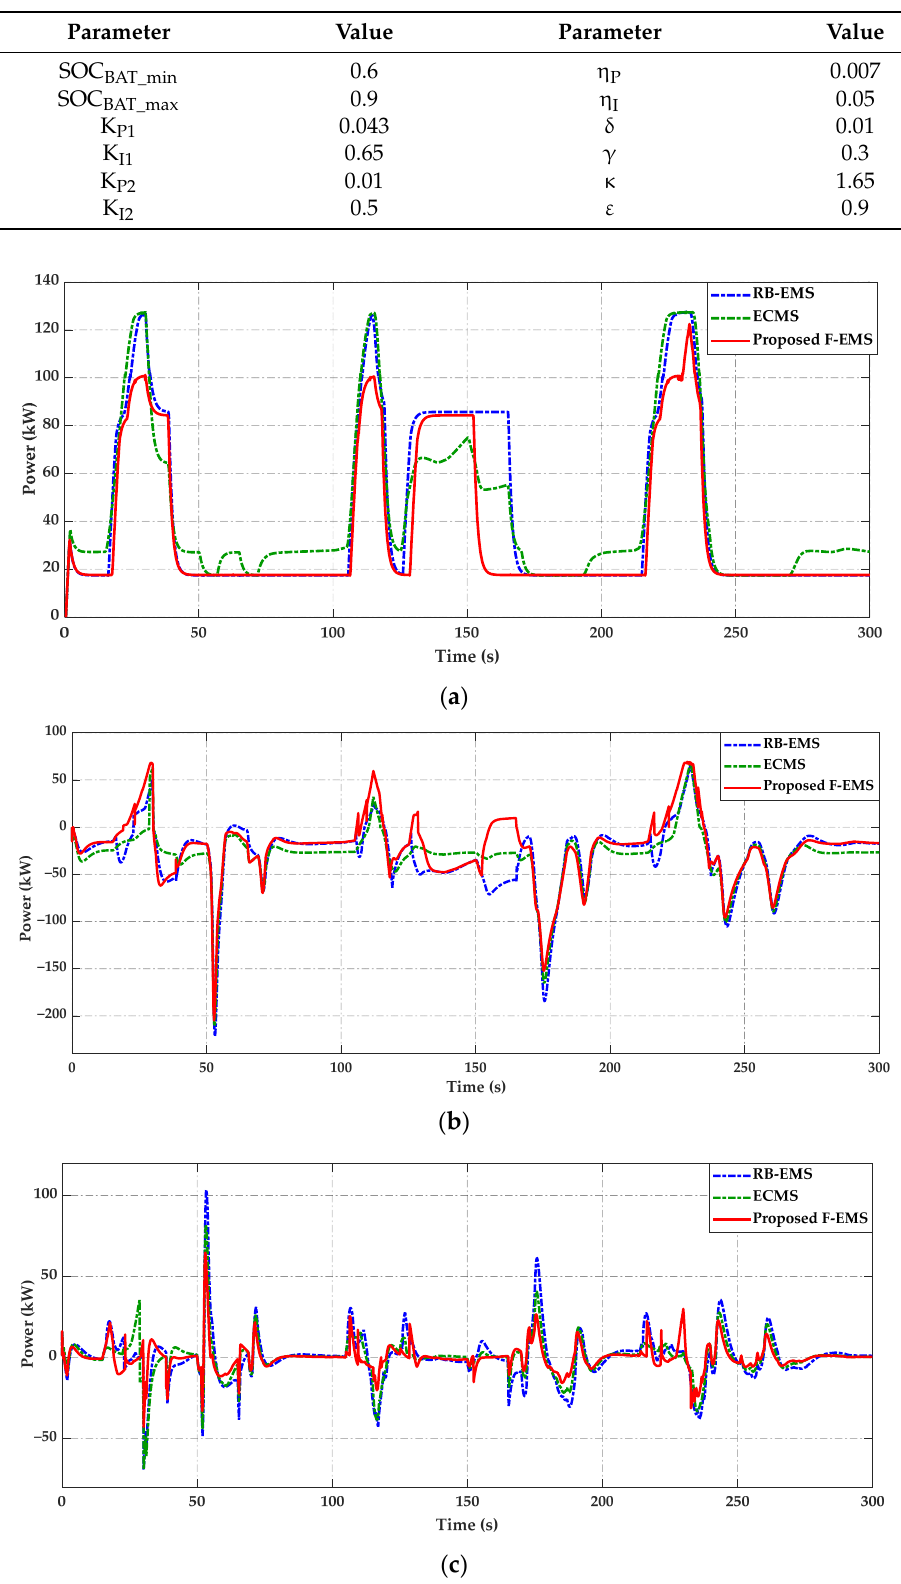
Figure 10. The comparison of power distribution from energy sources. ( a ) PEMFC; ( b ) BAT; ( c ) SC. The comparison of DC bus voltage corresponding to the load power demand is shown in Figure 11. By using the proposed F-EMS, the DC bus voltage is steadily maintained at around 750 V with a smaller fluctuation than using the RB-EMS and ECMS. In the change interval of the load, the DC bus peak voltage is in the range of ( ) → 746 753 V, approximated by a 1% voltage ripple, by using the proposed F-EMS. This result is better than the ones under the RB-EMS with the range of (